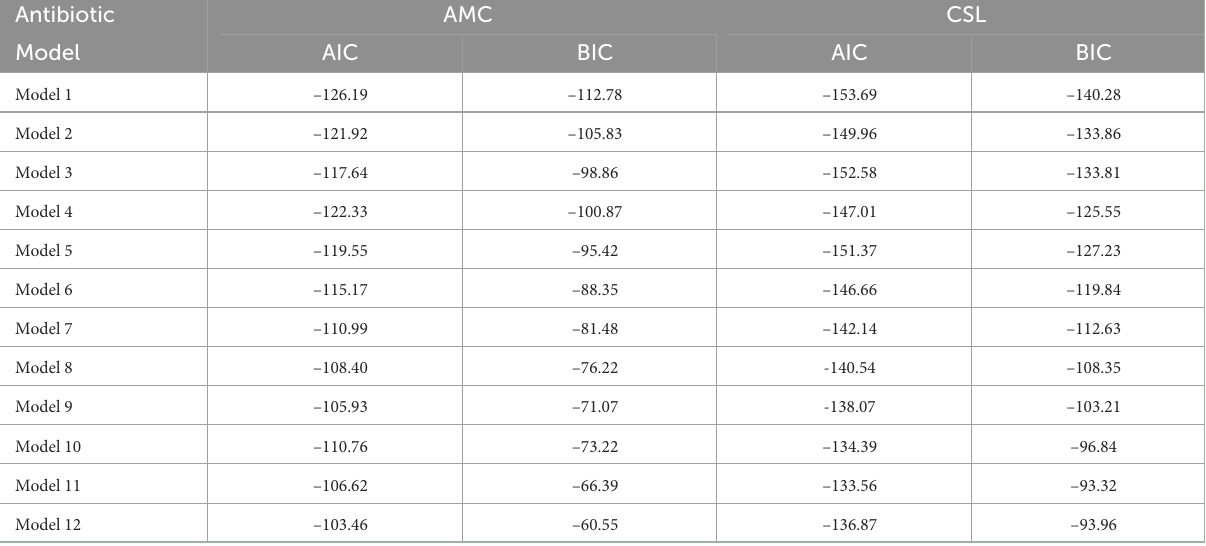
TABLE 4 AIC and BIC for D β AR(p) models for AMC and CSL data.